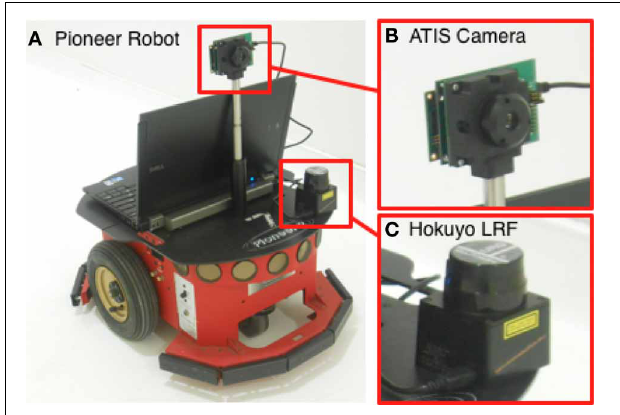
FIGURE 6 | Experimental setup: (A) the Pioneer 2, (B) the asynchronous event-based ATIS camera, (C) the Hokuyo laser range finder (LRF).